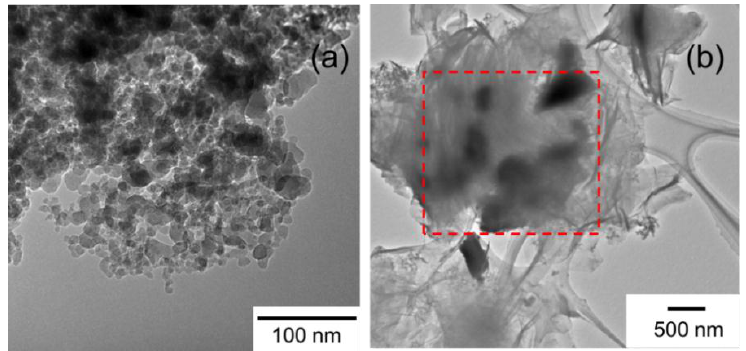
Figure 5. TEM images of ( a ) PP-OH; and ( b ) PP-modified graphene oxide (PP-GO) powder.